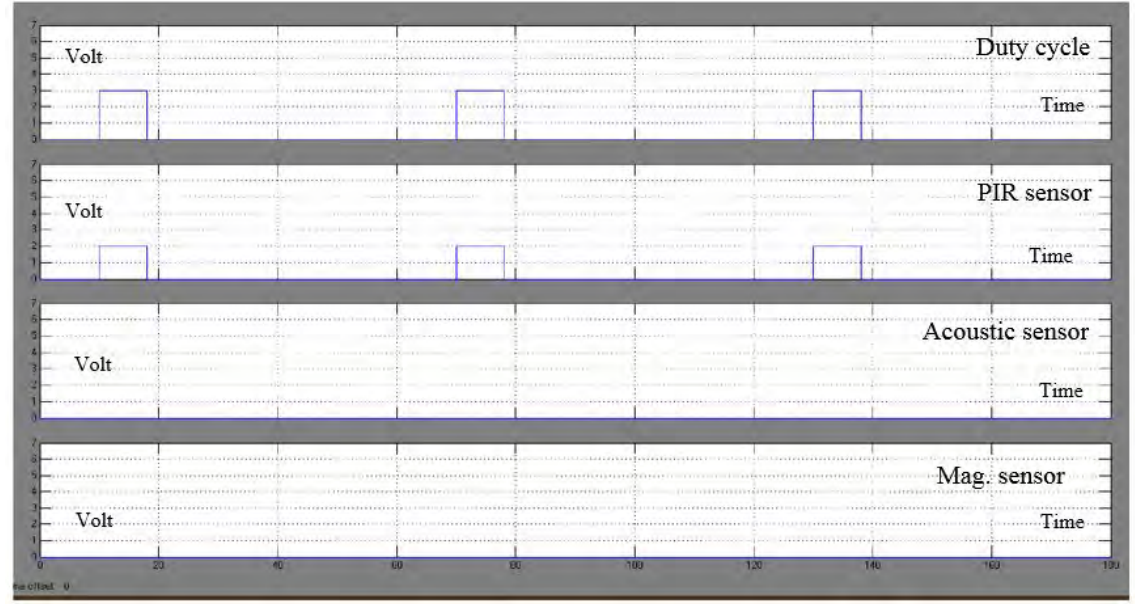
Figure 3. Scope1 (duty cycle and the output of PIR,acoustic, and magnetic